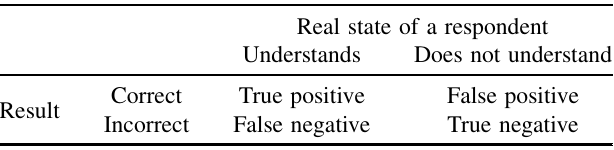
TABLE I. Decision table of answers.